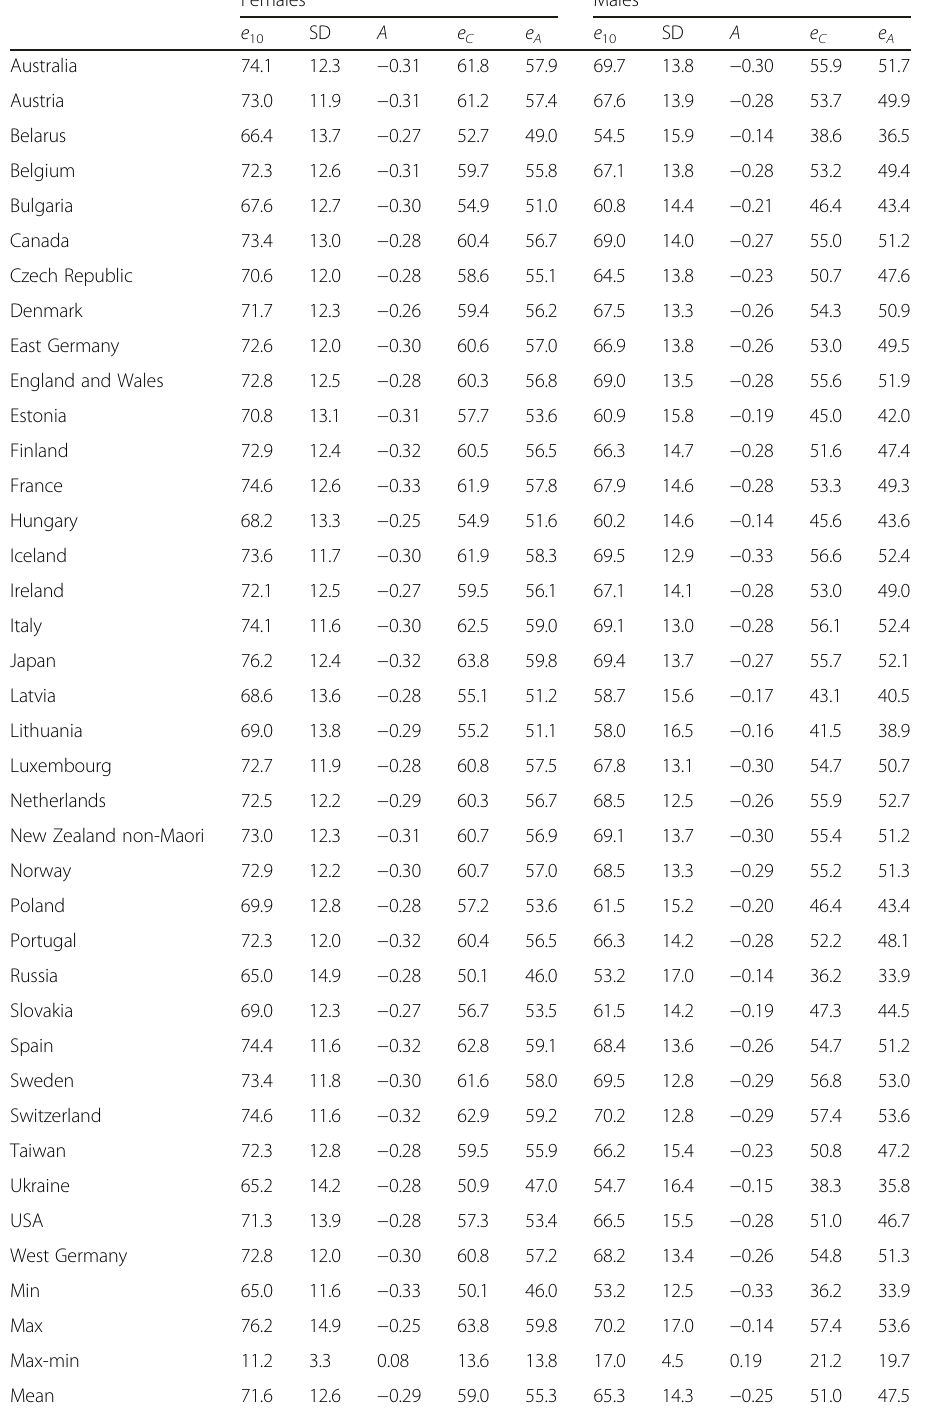
Table 3 Parameters of the life-table age-at-death distributions and the summary measures ( e 10 , e C , e A ) in 35 developed countries, by sex,